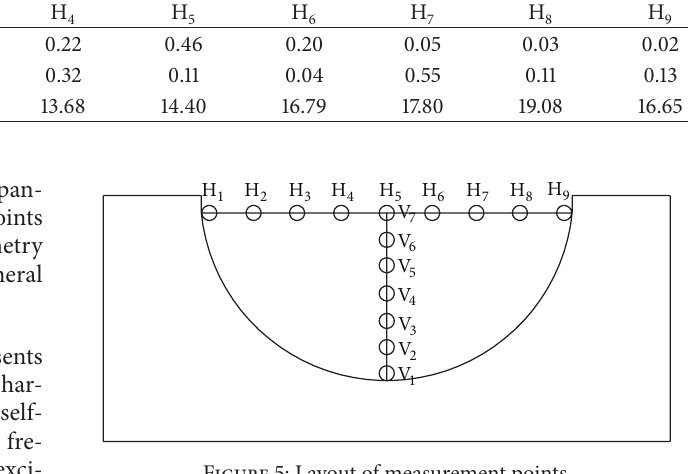
–H for base excitation of 100Hz (mm/s). 1 9